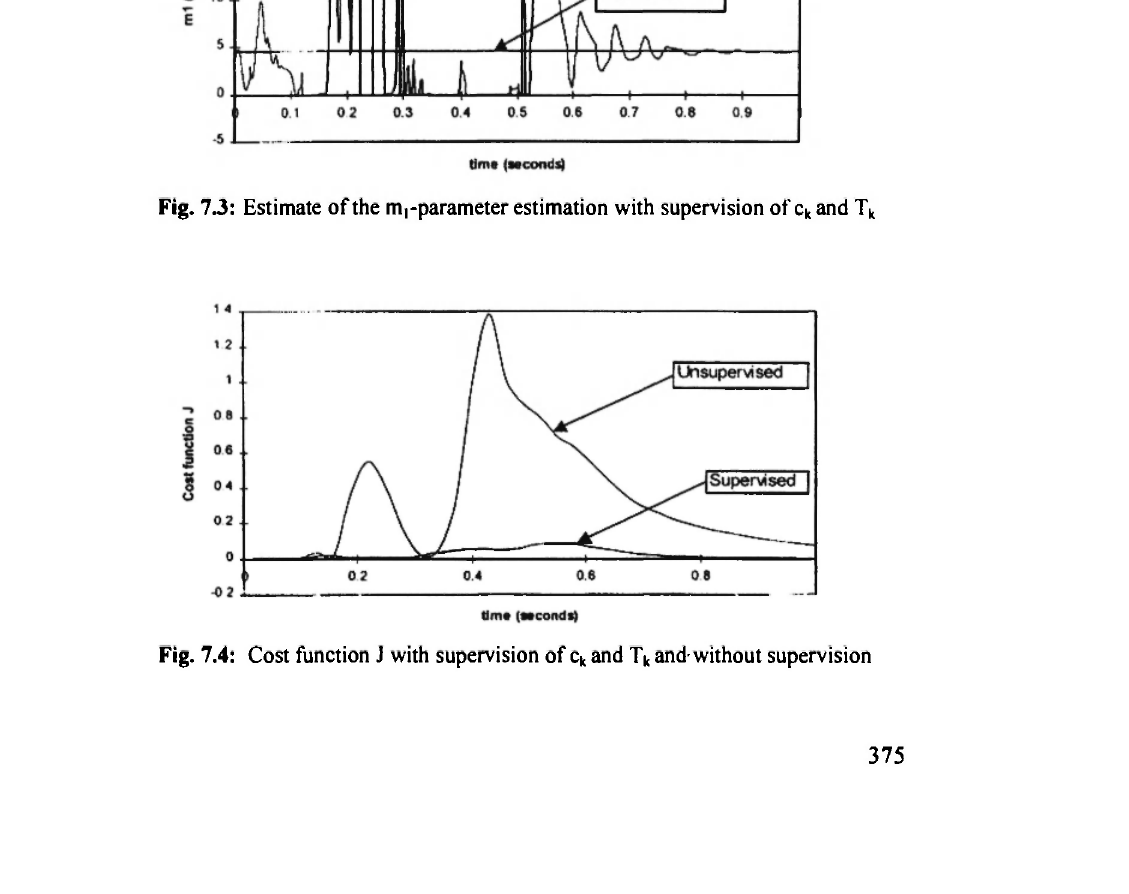
Fig. 7.3: Estimate of the m r parameter estimation with supervision of'c k and T k